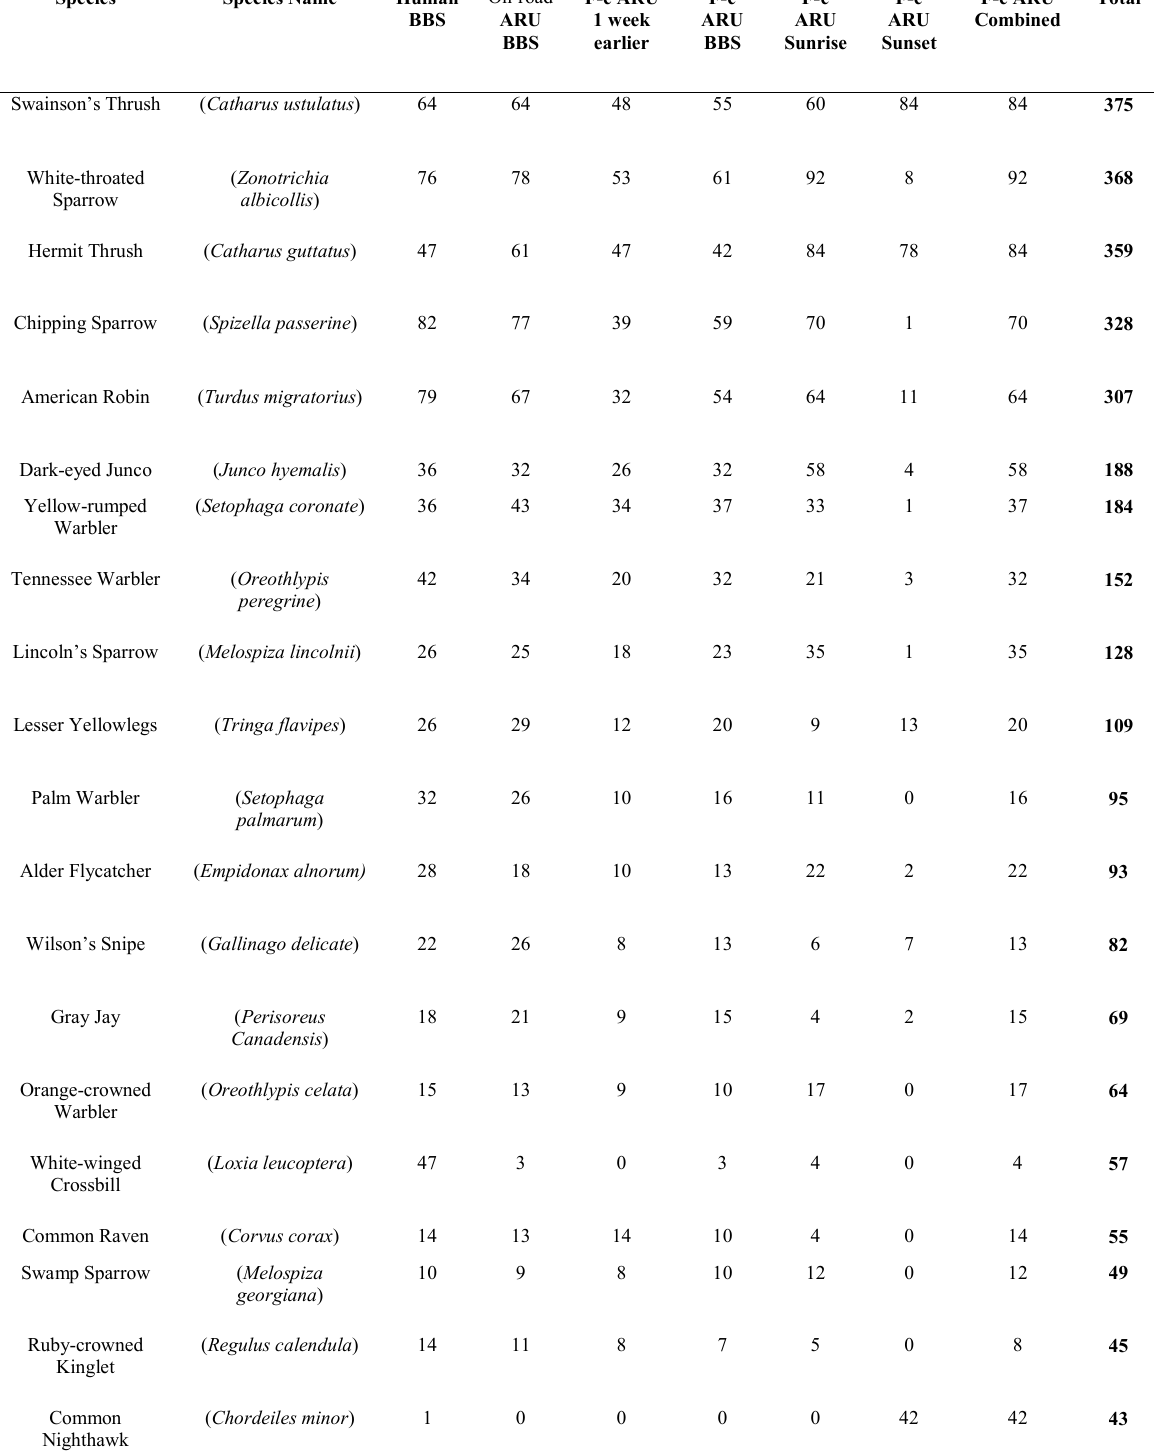
Table A2.1. Total number of detection per survey type and land cover for the 76 species detected during this study.